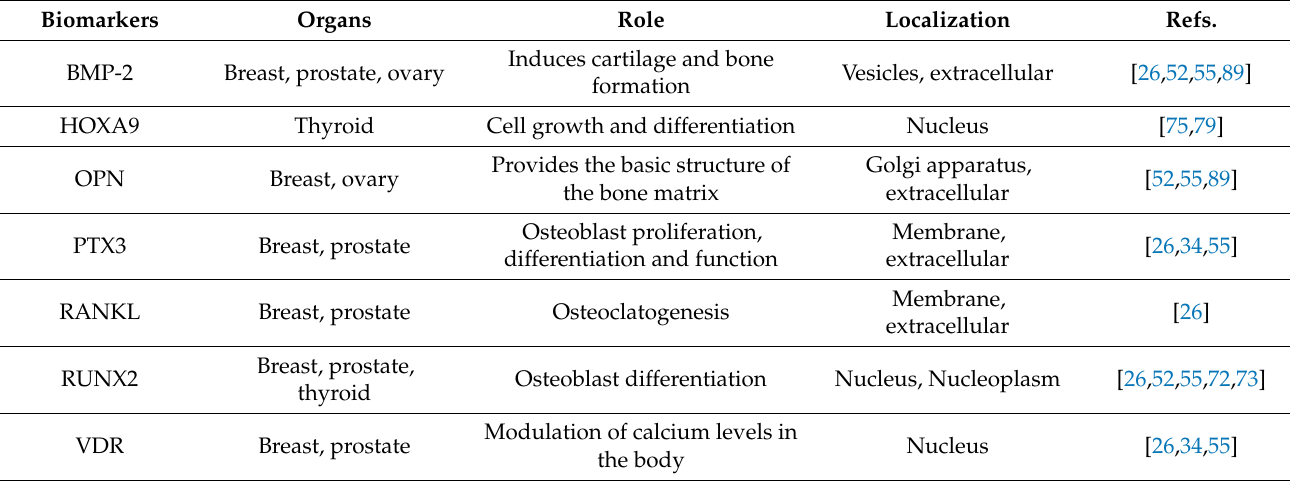
BMP2: Bone Morphogenetic Proteins-2; HOXA9: Homeobox protein Hox-A9; OPN: Osteopontin; PTX3: Pentraxin 3; RANKL: Receptor activator of nuclear factor kappa-B ligand; RUNX2: Runt-related transcription factor 2; VDR: Vitamin D